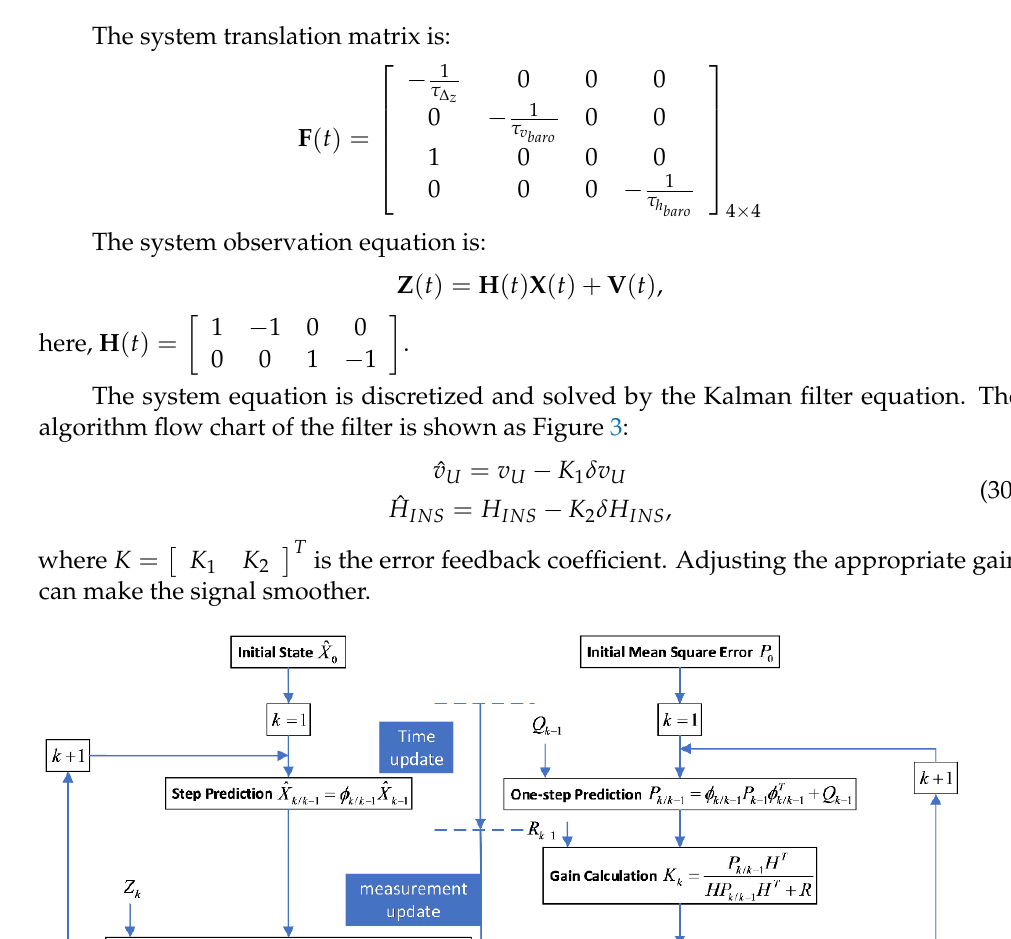
Figure 4. The experimental platform of the small fixed-wing UAV.